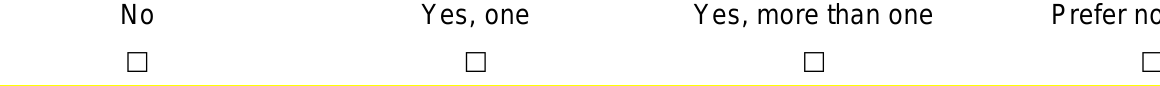
Cervical Cancer Awareness Measure Toolkit Version 2.1 Updated